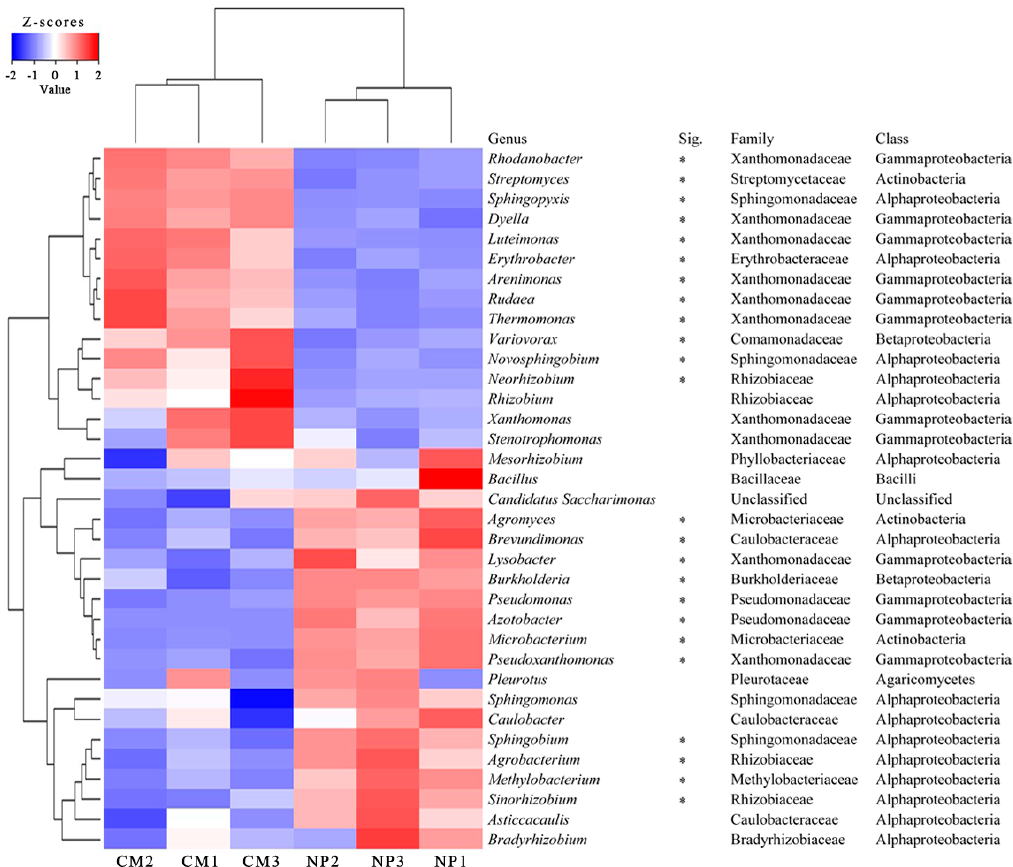
Figure 3. Heat map analysis of the top 35 most abundant genera in at least one soil sample using normalized abundance. Heat map is color-coded based on row z-scores. NP and CM represent the one-year cultured soil and two-year consecutively monocultured soil, respectively. Sig. represents significant differences for corresponding genera between two different treatments (* q < 0.05).